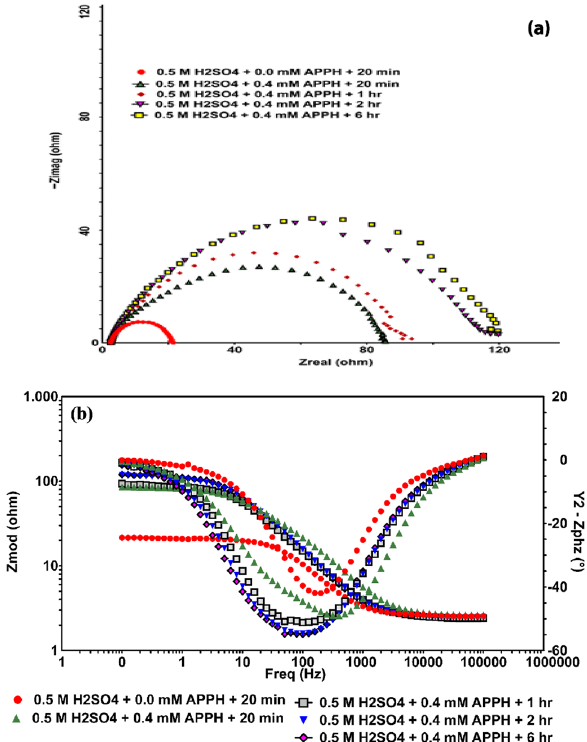
Figure 5. Impact of 6 h Immersion period of LCS corrosion in 0.5 M H 2 SO 4 containing 0.4 mM APPH ( a ) grave of Nyquist; and ( b ) grave of bode plots.